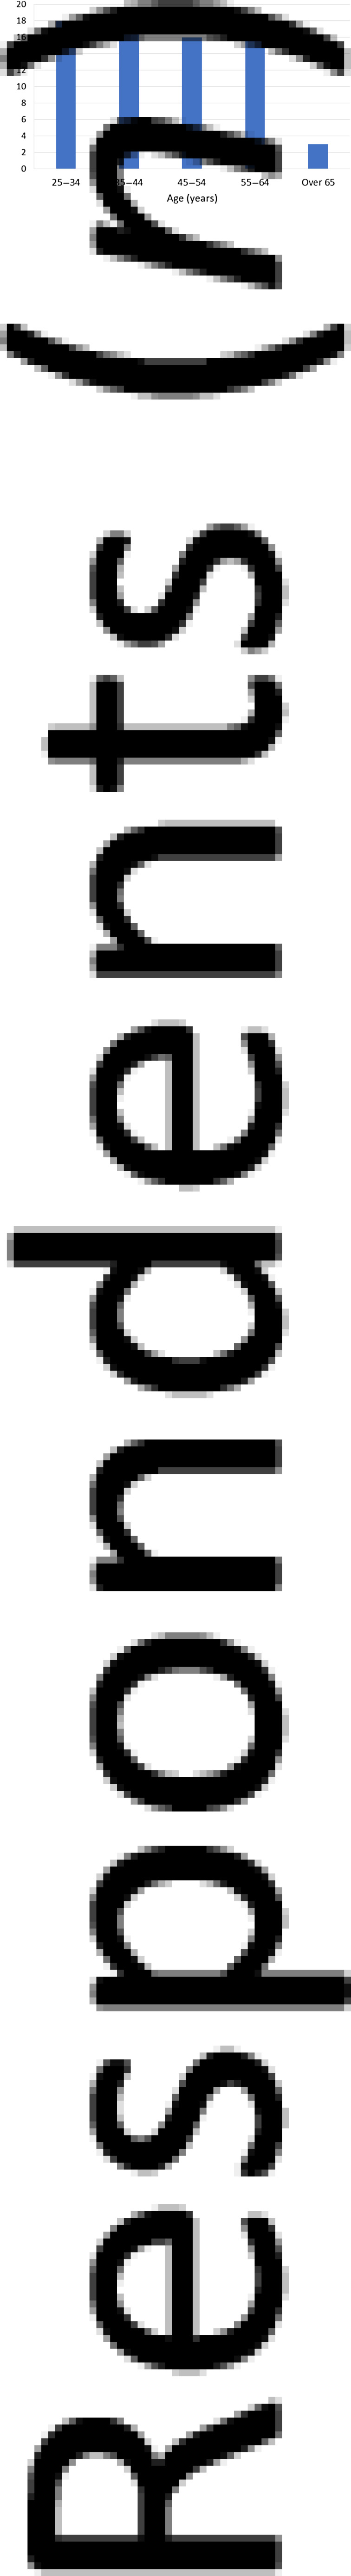
Age distribution.